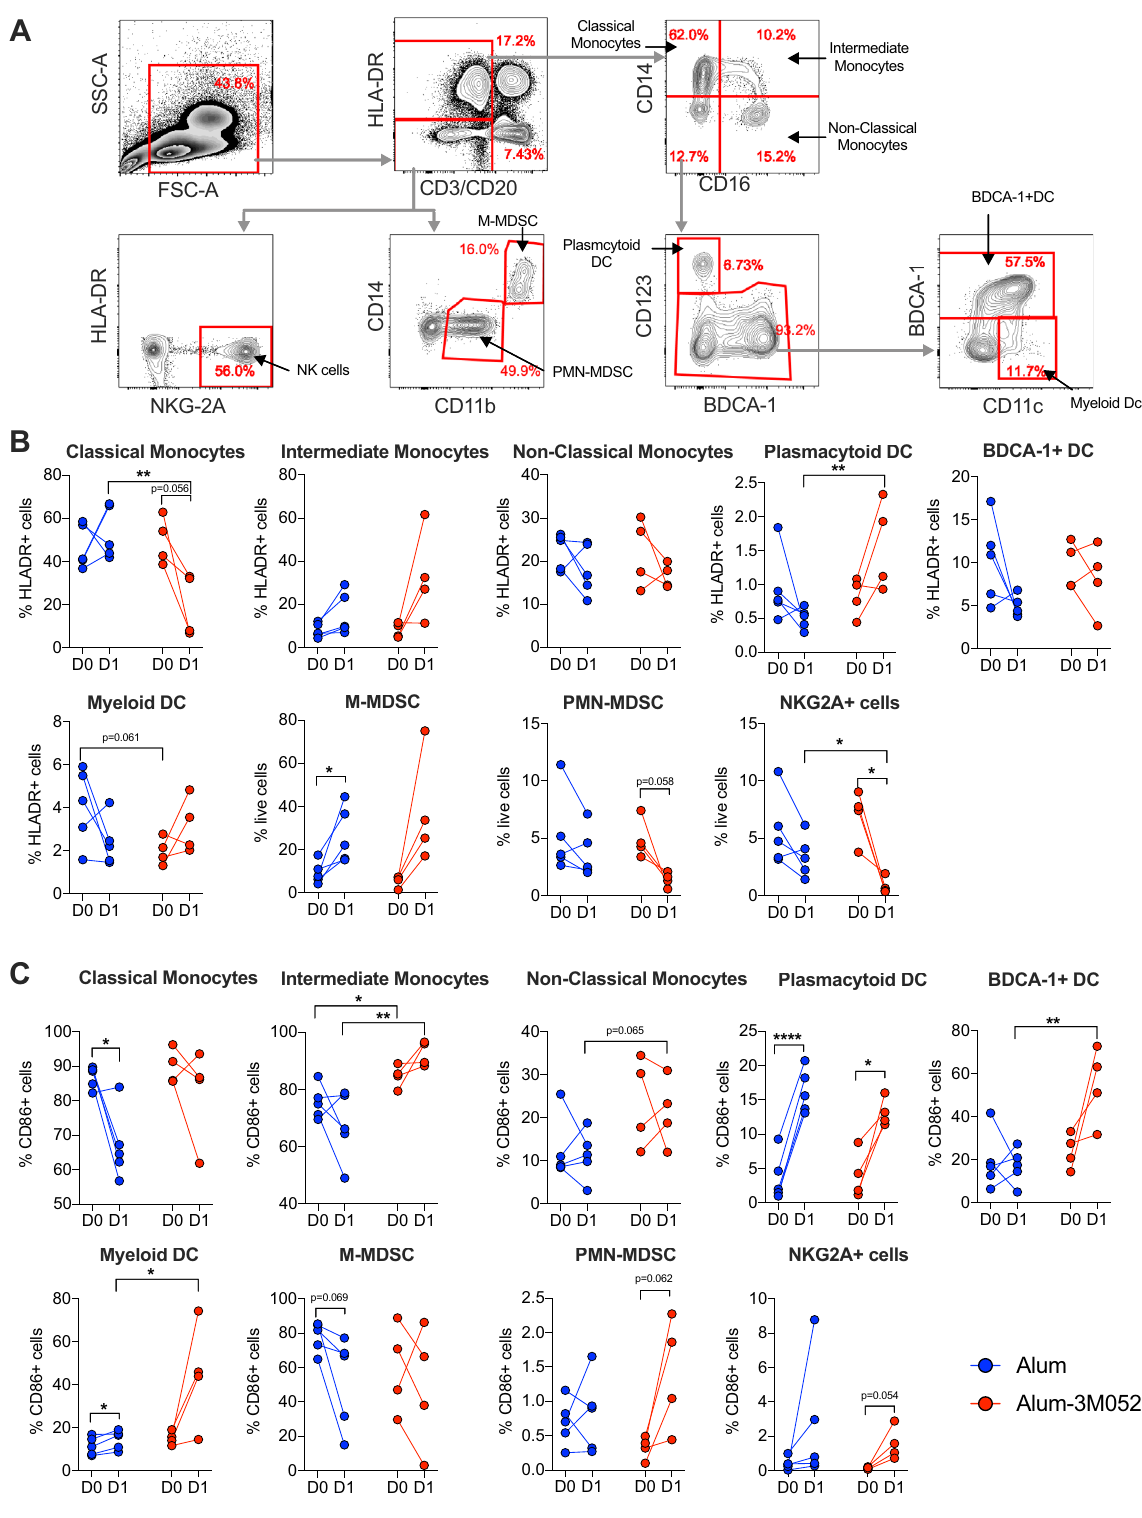
pre-infection) by Day 10 with a geometric mean titer of 651 that was 200-fold lower compared to the titer in vaccinated animals (Fig. 5H). In contrast, the RBD-binding antibody either stayed constant or decreased in all vaccinated animals except one animal each in alum and alum-3M-052 groups that showed a 2.4- and 7- fold increase compared to pre-infection titer (Fig. 5H). These were the same two animals that were positive for virus in the BAL